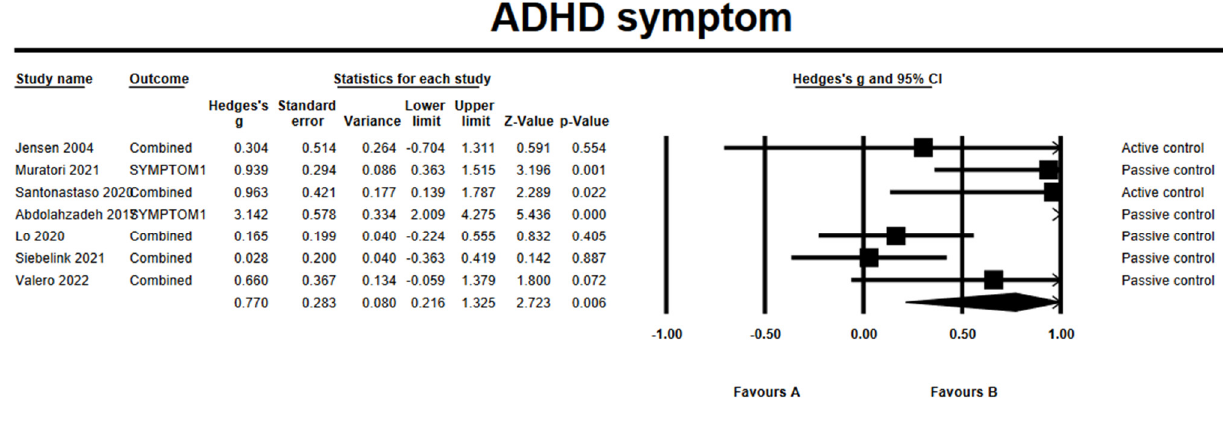
Figure 2. Forest plots of effect size for ADHD symptoms [28,31–33,36,38,39].